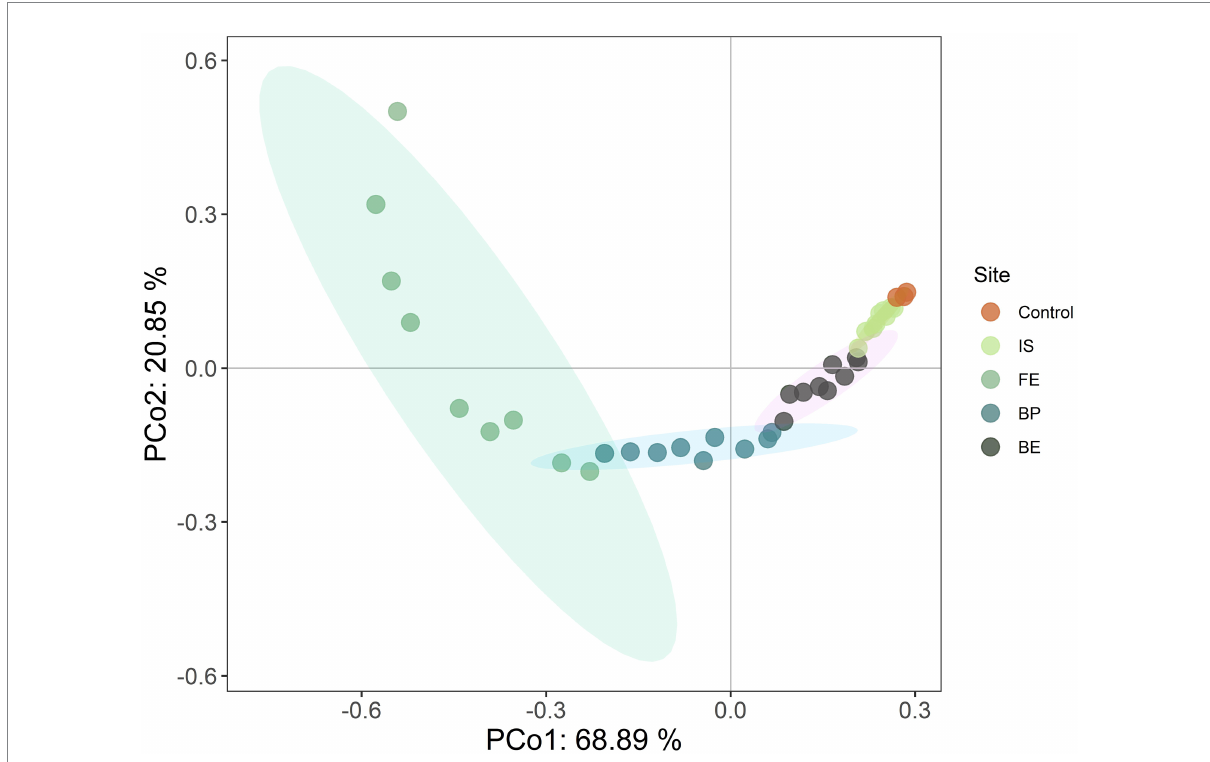
FIGURE 2 Principal coordinate analysis (PCoA) of plant community composition at different sites of PV